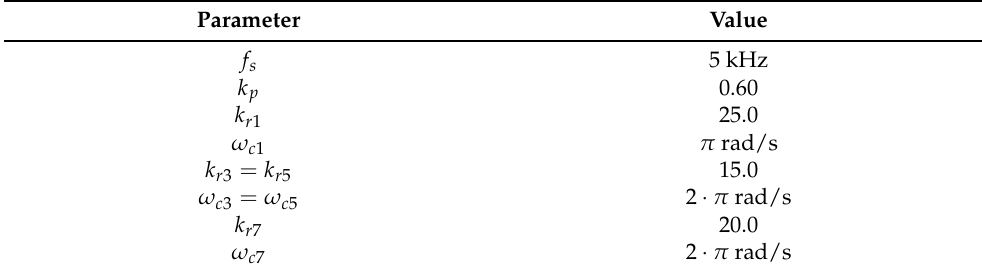
Table 2. Parameters of the voltage